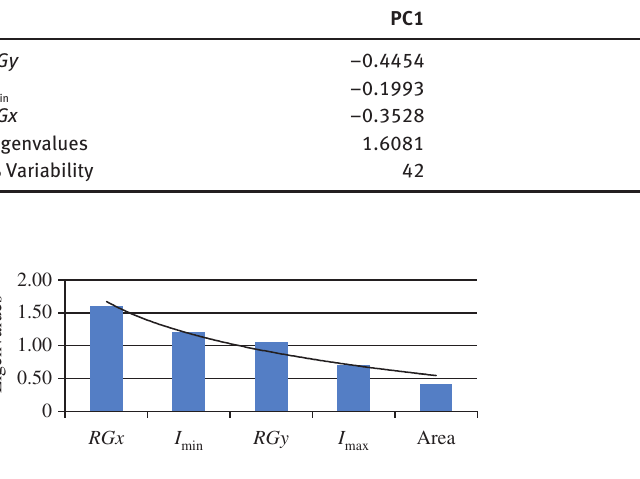
Figure 9: Bar Chart of Eigenvalues of PCA.